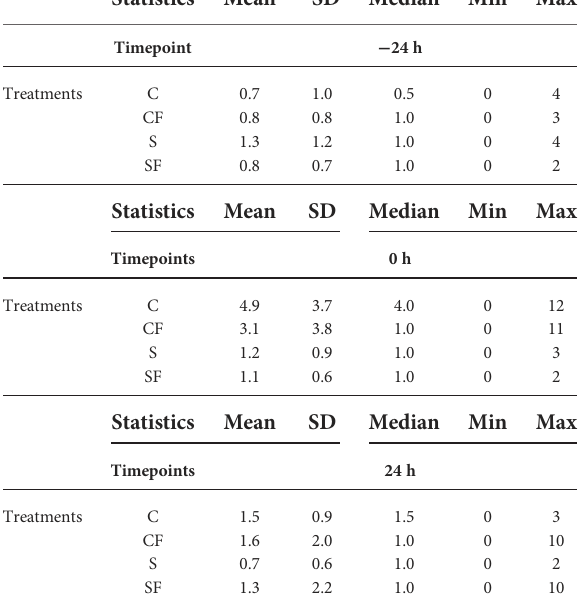
TABLE 4 Descriptive statistics for total UPAPS scores for treatment groups a across all timepoints b